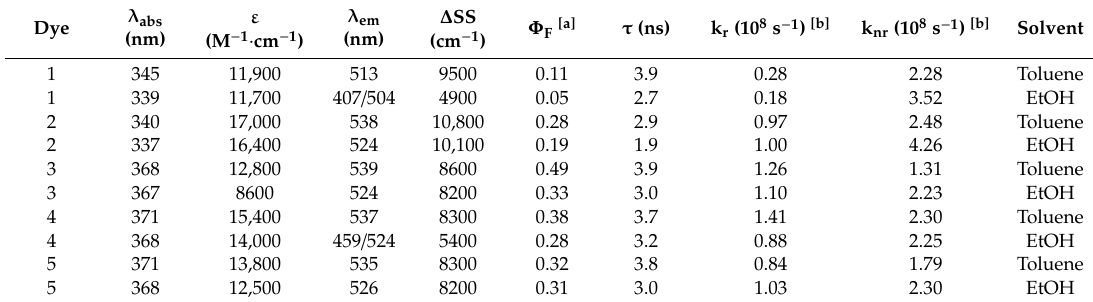
( λ exc = 488 nm, Φ = 0.88 in ethanol). [b] k r (10 8 s − 1 ) and k nr (10 8 s − 1 ) were calculated using the following equations: k r = Φ F / τ , k nr = (1 − Φ F )/ τ .